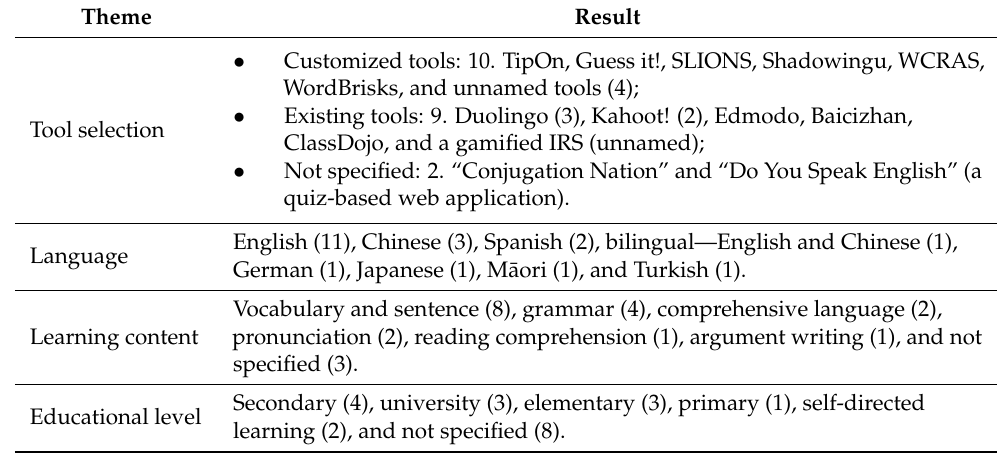
Table 2. Substantive features of the selected empirical